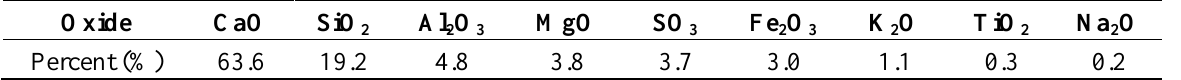
Table 1. Oxide composition of the cement.